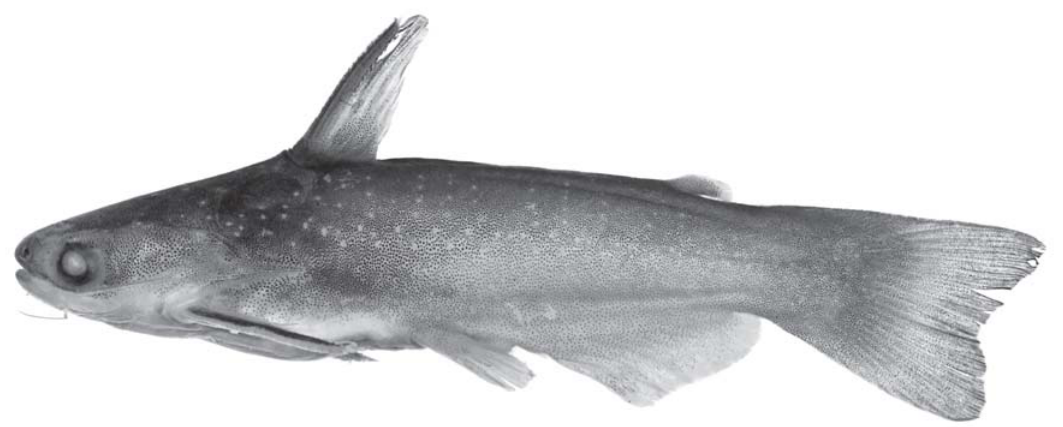
Fig. 6. Auchenipterichthys longimanus , INHS 61570, 67 mm SL; Venezuela, Amazonas, caño Pozo Azul, río Orinoco drainage (5°45’49"N,